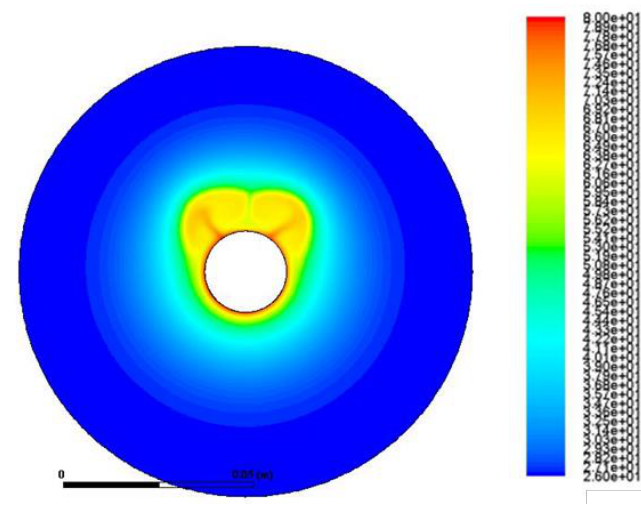
Figure 11. Temperature field at 900 s.